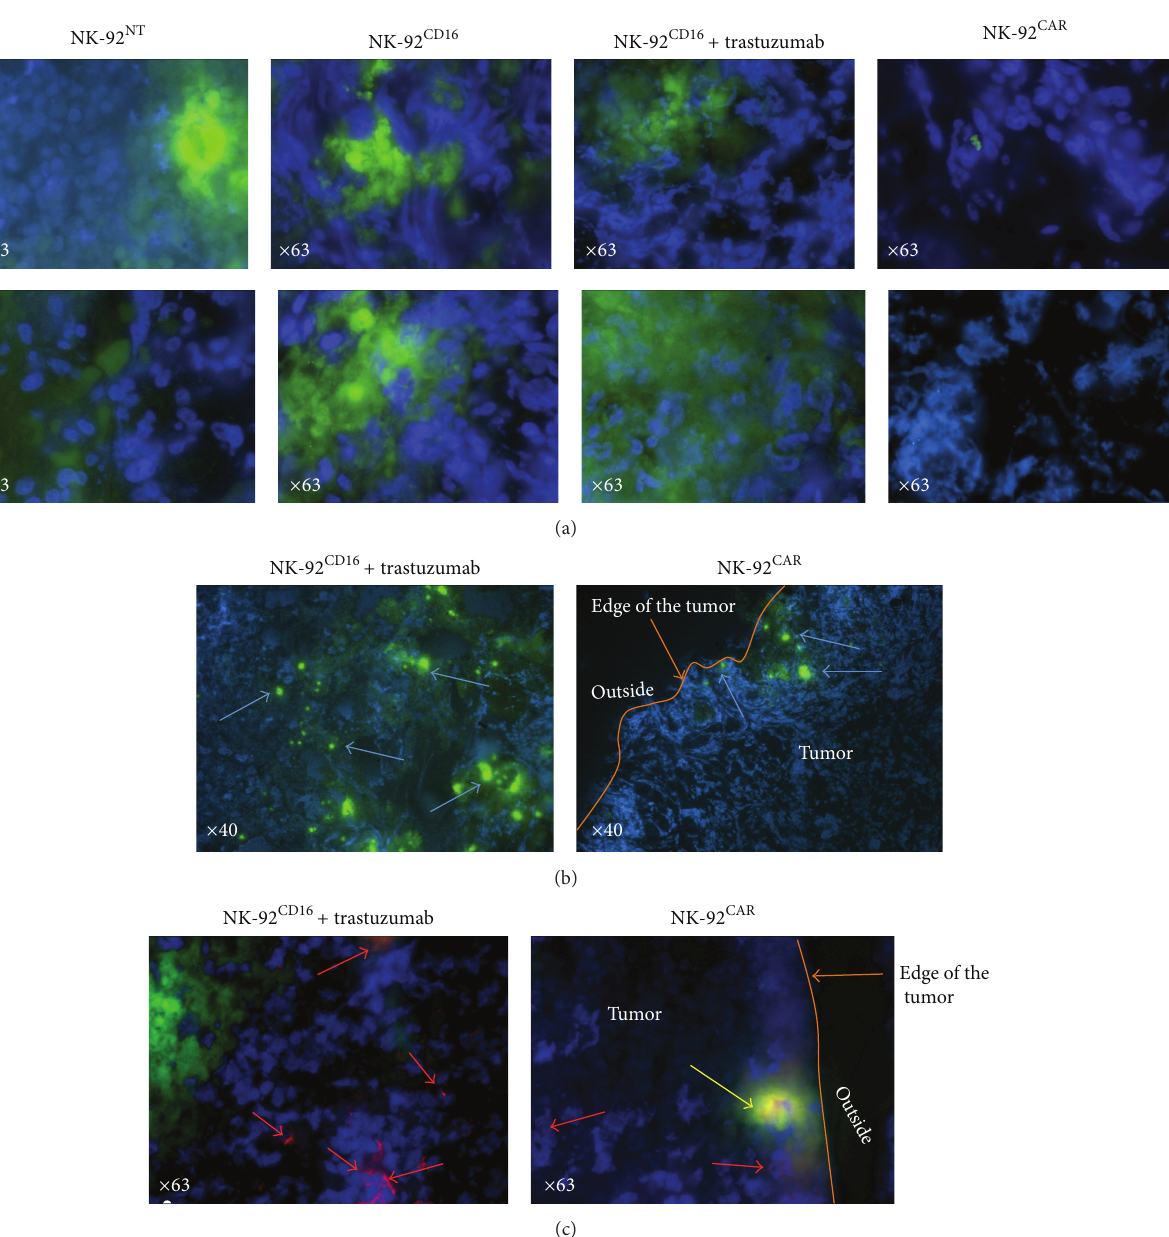
Figure 6: Immunohistochemical analysis of BT474 tumor sections. NK-92 were directly stained with CSFE and tumor cells were visualized by counterstaining with DAPI. (a) NK- 92 NT and NK- 92 CD 16 could be found in different parts of the tumors, either as a cluster or as single cells and preinjection of trastuzumab did not affect NK- 92 CD 16 frequency within the tumor (panels 2 and 3). Panel 4 shows the absence of NK- 92 CAR within the tumors. (b) Comparison of effectors spreading between NK- 92 CD 16 and NK- 92 CAR within the tumors using direct CFSE visualisation (green): NK- 92 CAR appeared clustered at the edge of the tumor only whereas NK- 92 CD 16 are observed everywhere in the tumor. (c) Merge colocalization (yellow arrow) of mice macrophages (red) using Iba1 staining and NK- 92 CAR cells (green) are always located at the edge of the tumor (blue) whereas isolated macrophages (red arrow) can be found everywhere within the tumor. This was not observed with NK- 92 CD 16 . Typical representative images are